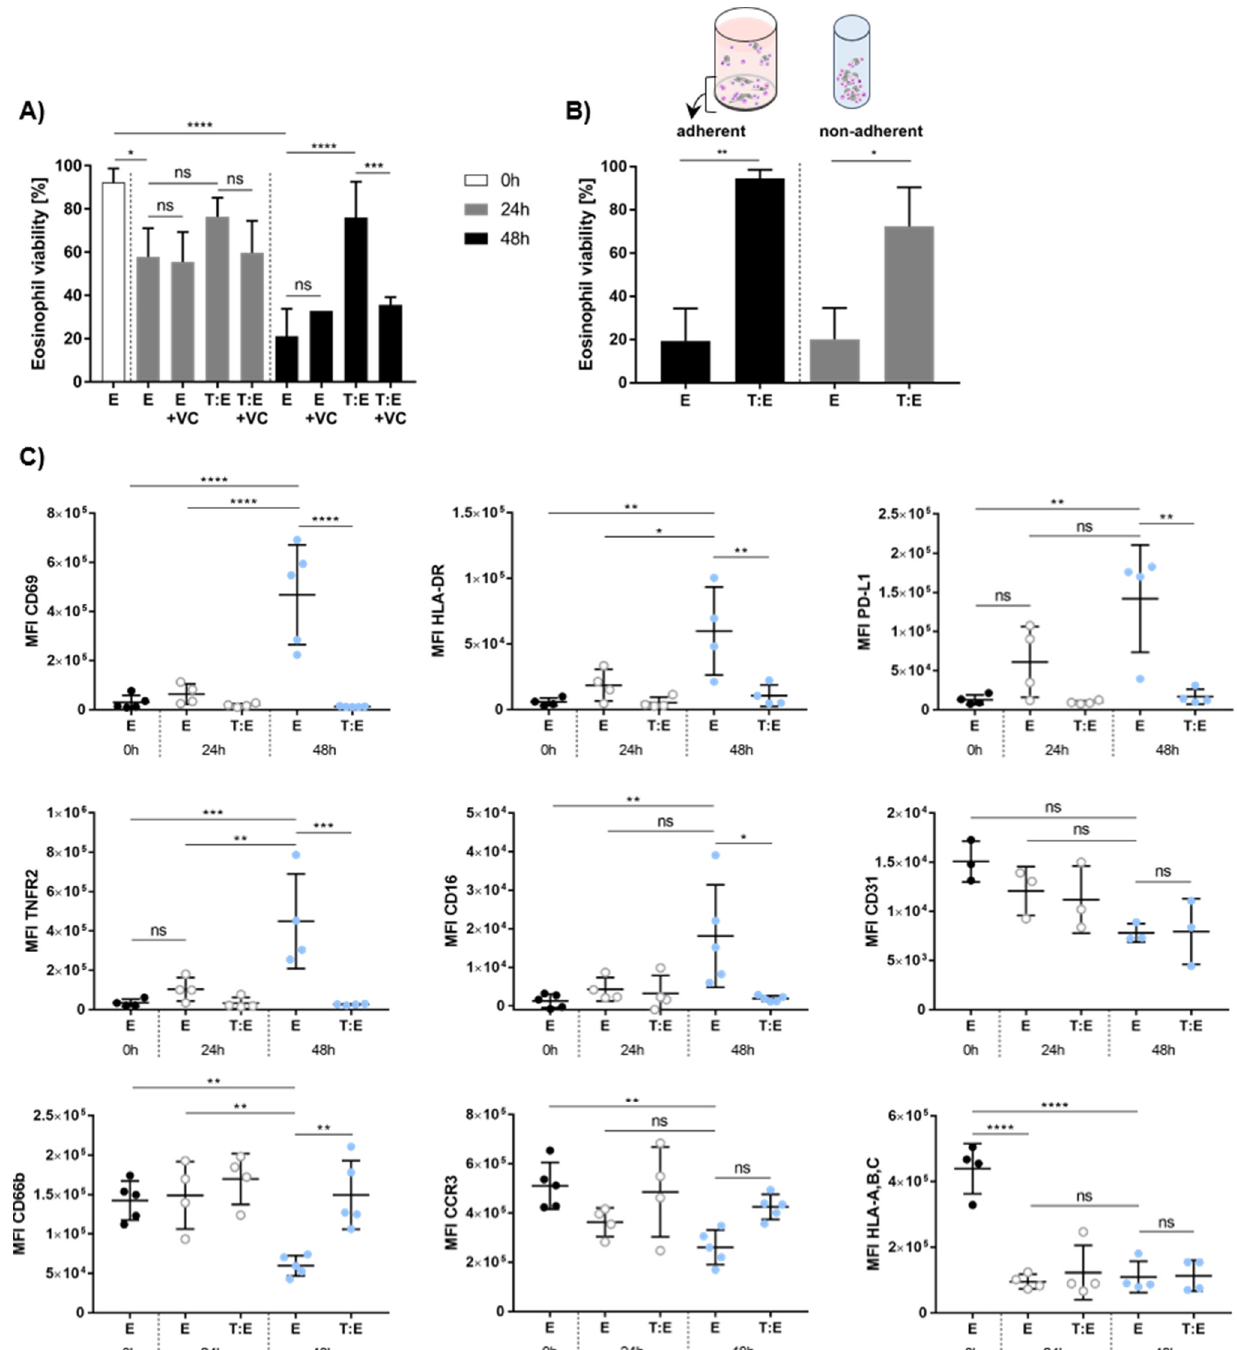
Figure 4. In vitro viability and phenotypic characterization of eosinophils in co-culture with melanoma cells. ( A ) Eosinophil viability increases upon co-culture with melanoma cells. Non-adherent (co-)culture of eosinophils and MaMel63a cells in medium or medium containing 1 µM vemurafenib and 100 nM cobimetinib for 24 and 48 h. Mean percentage of eosinophil viability ± standard deviation (SD) shown for one to nine independent experiments. ( B ) MaMel63a cells were co-cultured with eosinophils in a 1:7.5 tumor to effector cell ratio for 48 h. Separate measurement of viability of adherent (24-well plate) and non-adherent (polypropylene tube) eosinophils. Eosinophils in co-cultures with melanoma cells are significantly more viable. Mean percentage of eosinophil viability ± SD is displayed from two to five independent experiments. ( C ) Phenotypic characterization of peripheral blood eosinophils from healthy donors in (co-)culture with or without MaMel63a cells. Phenotypic epitopes were analyzed at time points 0 h, 24 h and 48 h using flow cytometry. The MFI of the target epitopes on eosinophils were plotted and the expression levels at